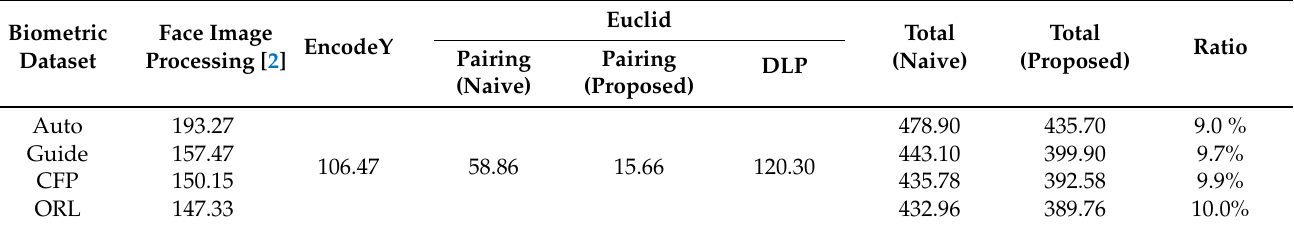
Table 3. Performance improvement in the facial verification system using the proposed method compared to the Naive method (times in